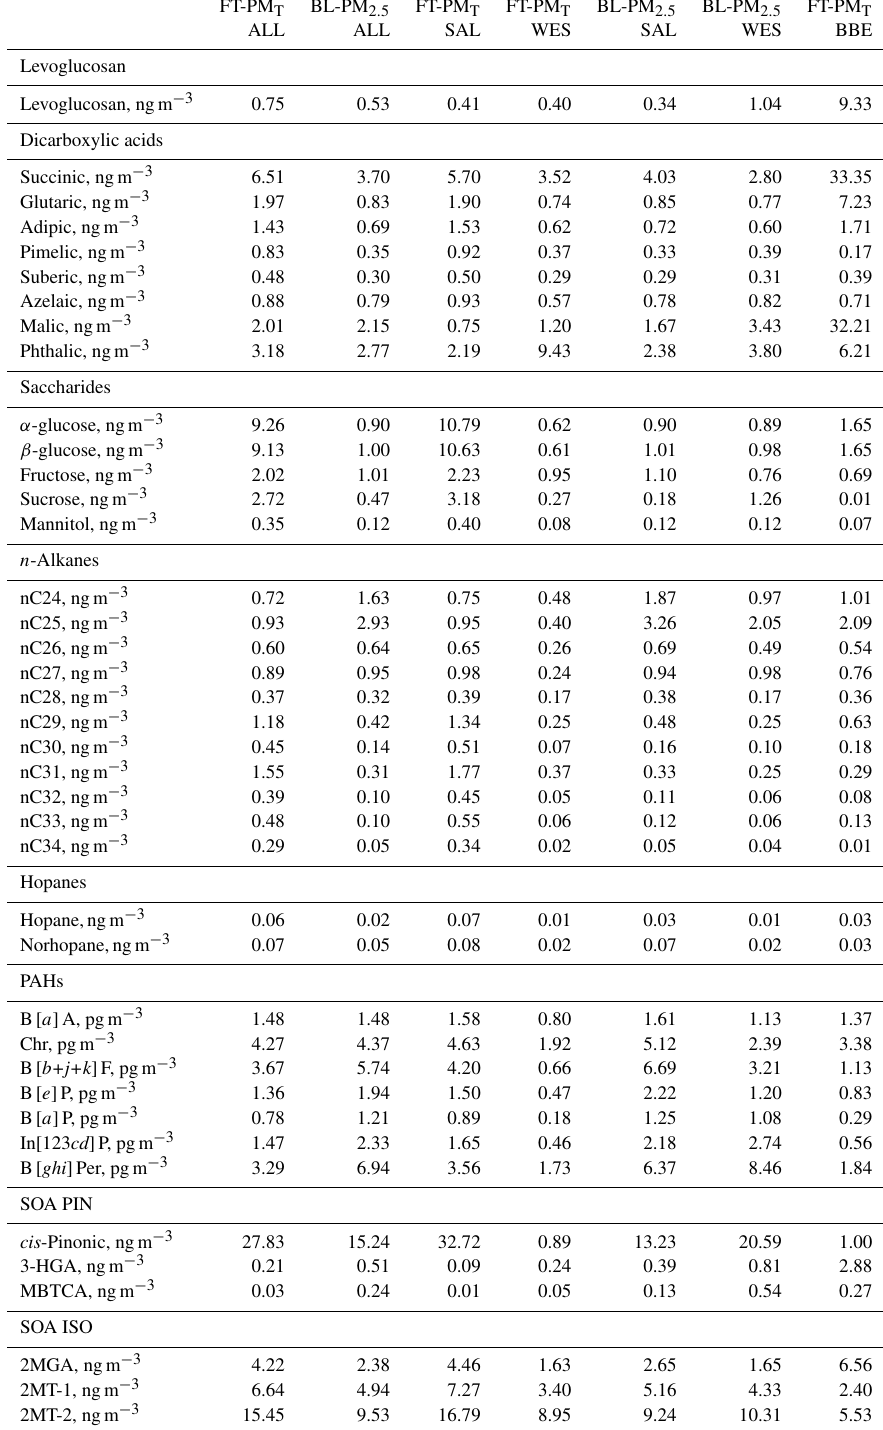
Table 2. Average concentration of the selected organic species for (i) FT-PM T and BL-PM 2 . 5 taking into account all samples, (ii) FT-PM T and BL-PM 2 . 5 collected within the Saharan Air Layer (SAL), (iii) FT-PM T and BL-PM 2 . 5 collected within the westerlies (WES) without the FT-PM T biomass burning event and (iv) FT-PM T biomass burning event